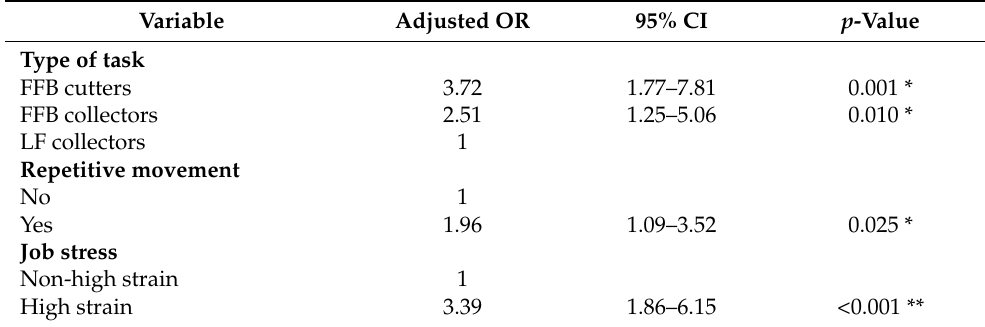
Table 5. Multivariate analysis of shoulder MSDs during the past 12